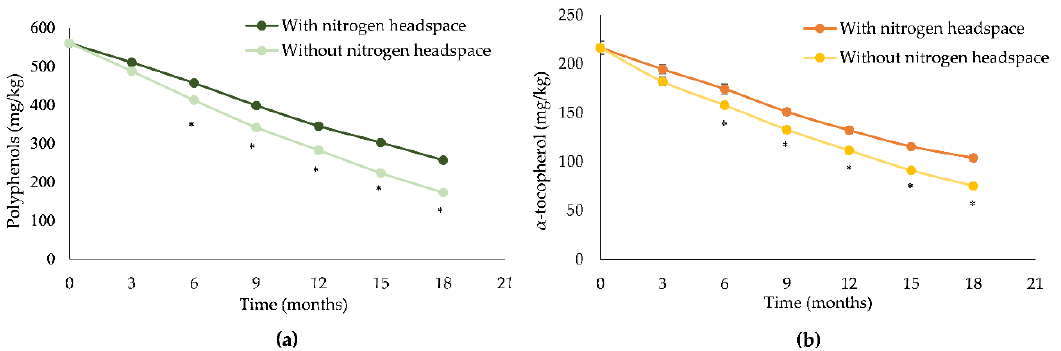
Figure 1. Poyphenols ( a ) and α -tocopherol ( b ) content decay of EVOOs with and without a nitrogen headspace during storage time. * p < 0.001 vs EVOO with a nitrogen headspace.